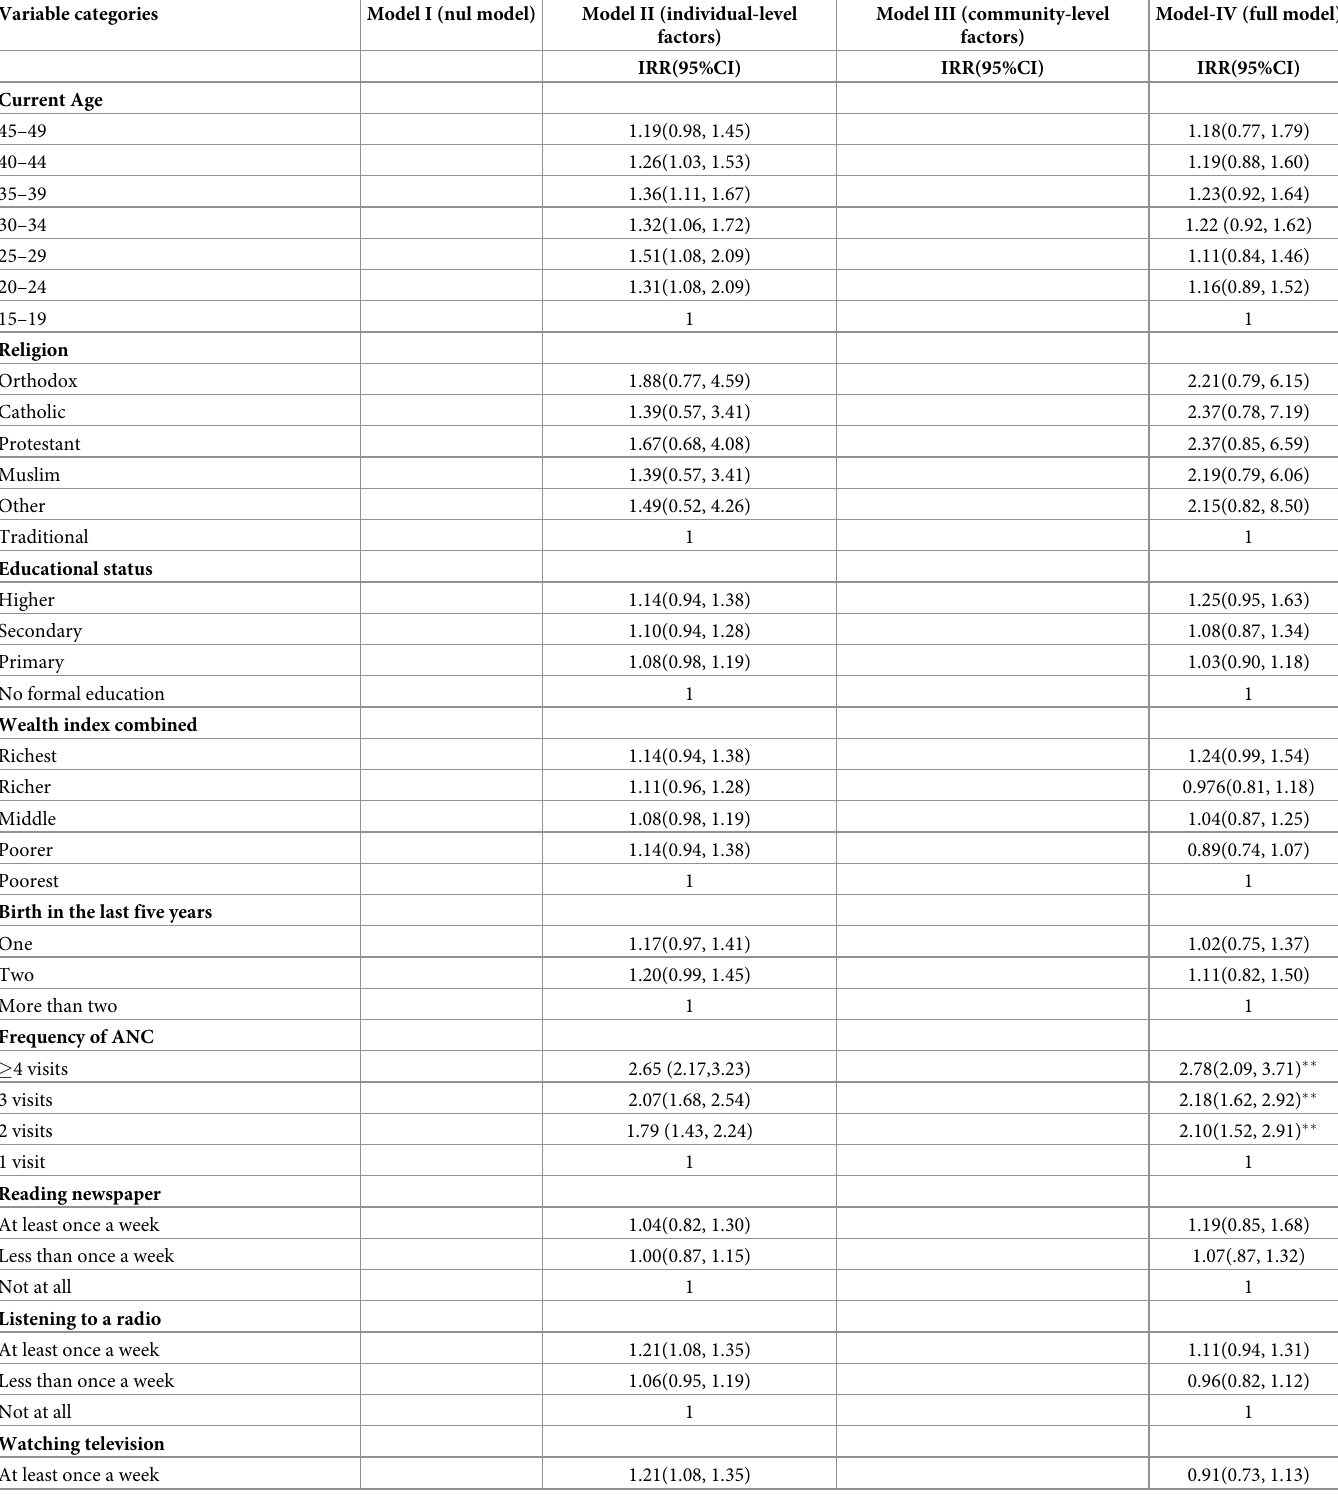
Table 6. Results of a multivariable mixed-effect negative binomial regression to identify the determinants of uptake of items of BPCR during ANC visit, Ethiopia